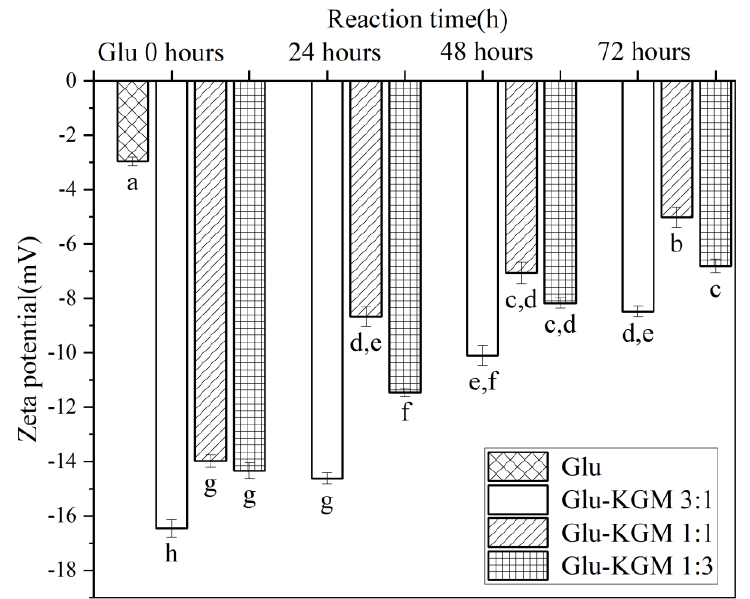
Figure 7. Zeta potential of gluten, mixtures, and conjugates, respectively. The results with different letters were significantly different ( p < 0.05).